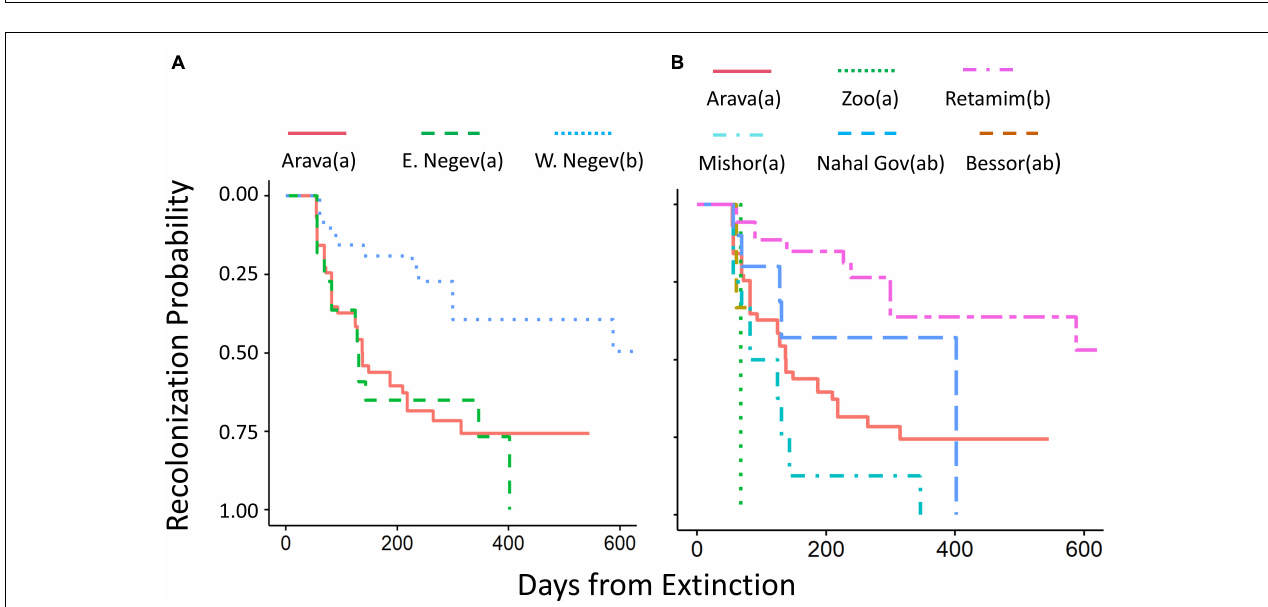
FIGURE 4 | Kaplan-Meier survival curves for C. citricola colonies by initial colony size (A) and by substrate and region (B) .